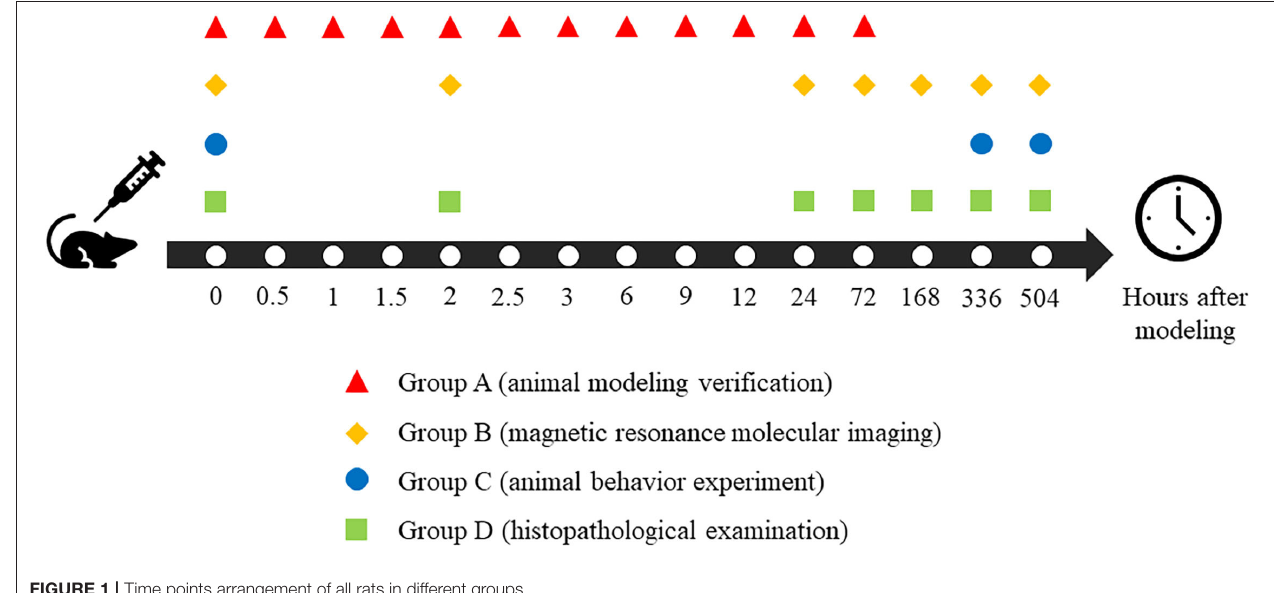
FIGURE 1 | Time points arrangement of all rats in different groups.